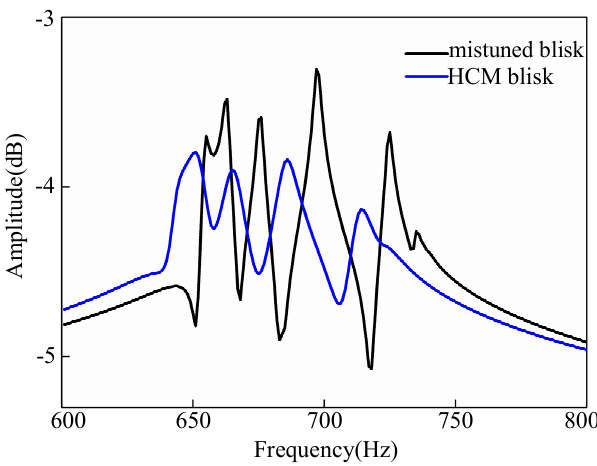
Figure 9. Frequency response functions of mistuned blisk and HCM blisk.